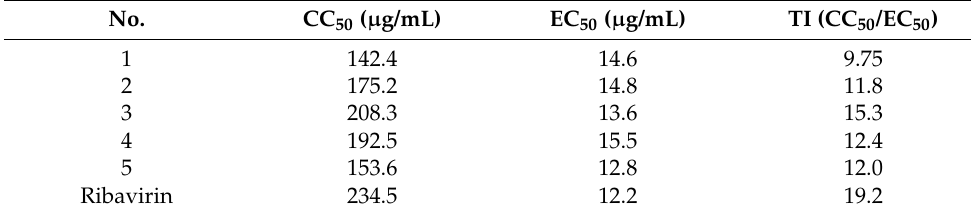
Table 5. Anti-rotavirus activity of compounds 1 – 5